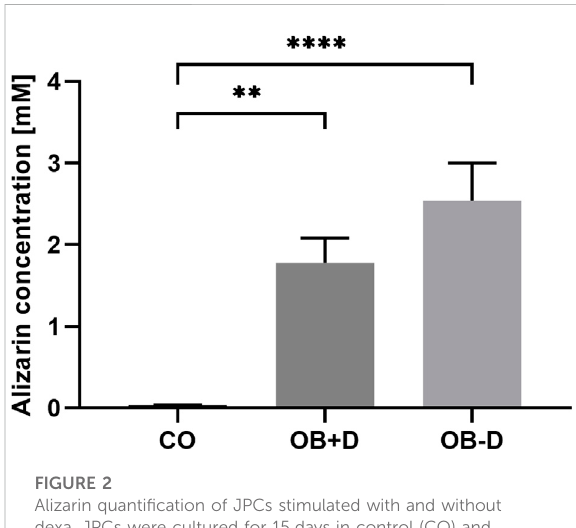
FIGURE 2 Alizarin quanti fi cation of JPCs stimulated with and without dexa. JPCs were cultured for 15 days in control (CO) and osteogenic medium with (OB+D) and without (OB − D) dexa. Calcium phosphate precipitates were stained with Alizarin dye. Bound dye was solubilized and quanti fi ed photometrically. Meanvalues± SEM werecalculated andcomparedusing one-way ANOVA and Tukey ’ s multiple comparison test (n = 9, ** = p < 0.01, **** = p <